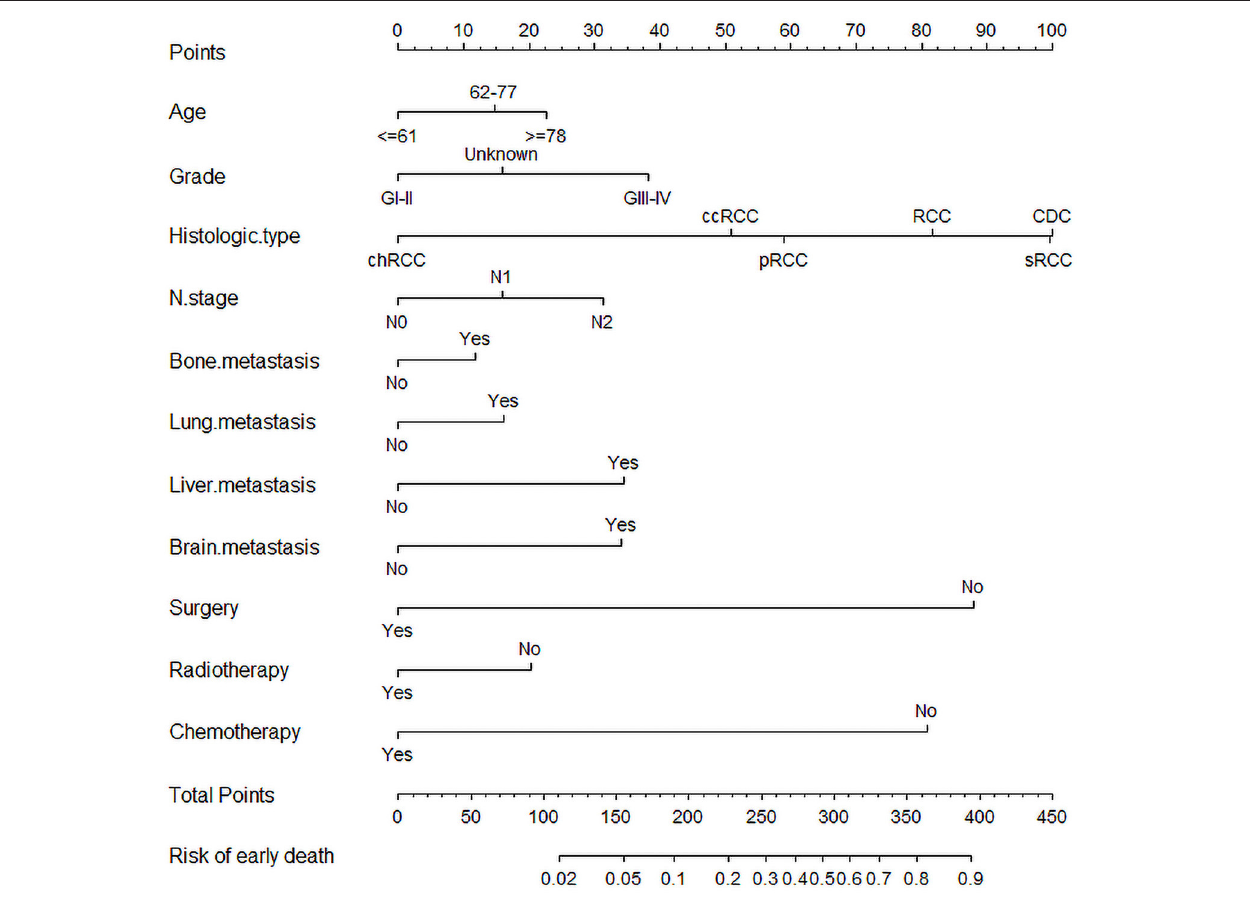
cancer-specific cause for metastatic renal cell carcinoma were 30.2 and 28.1%, respectively. In addition, our subjects were not only patients treated with TKIs, but all patients with mRCC, and more patients and risk factors were included. Exploring